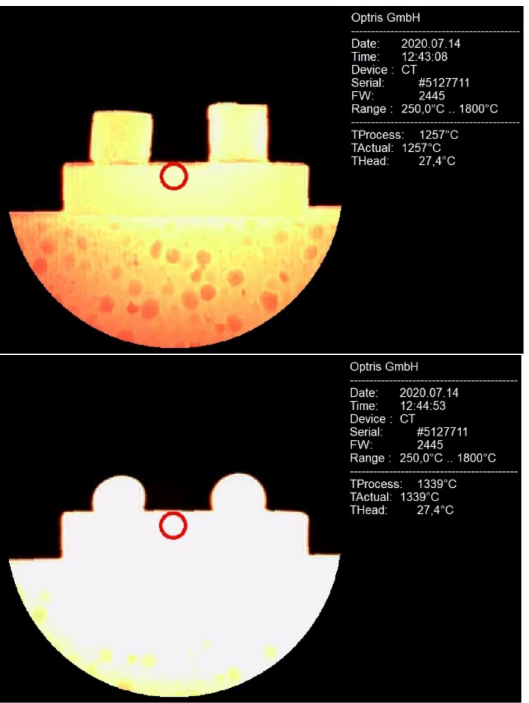
Figure 1. View of sample photos recorded during the ash melting